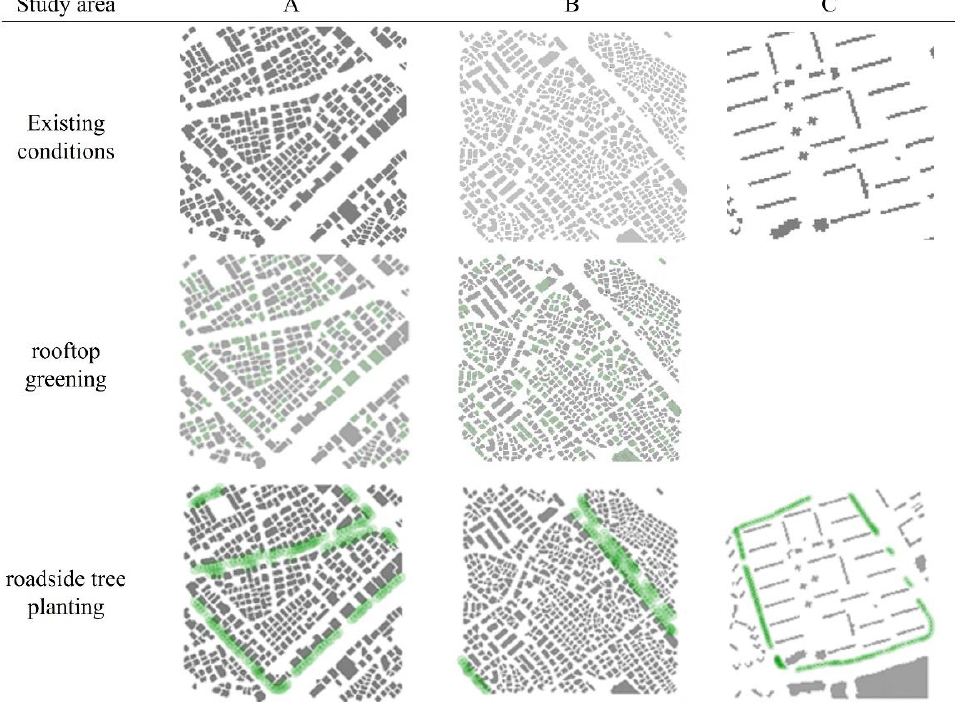
Figure 11. Temperature reduction effect of area A. Figure 12. Temperature reduction effect of area B.